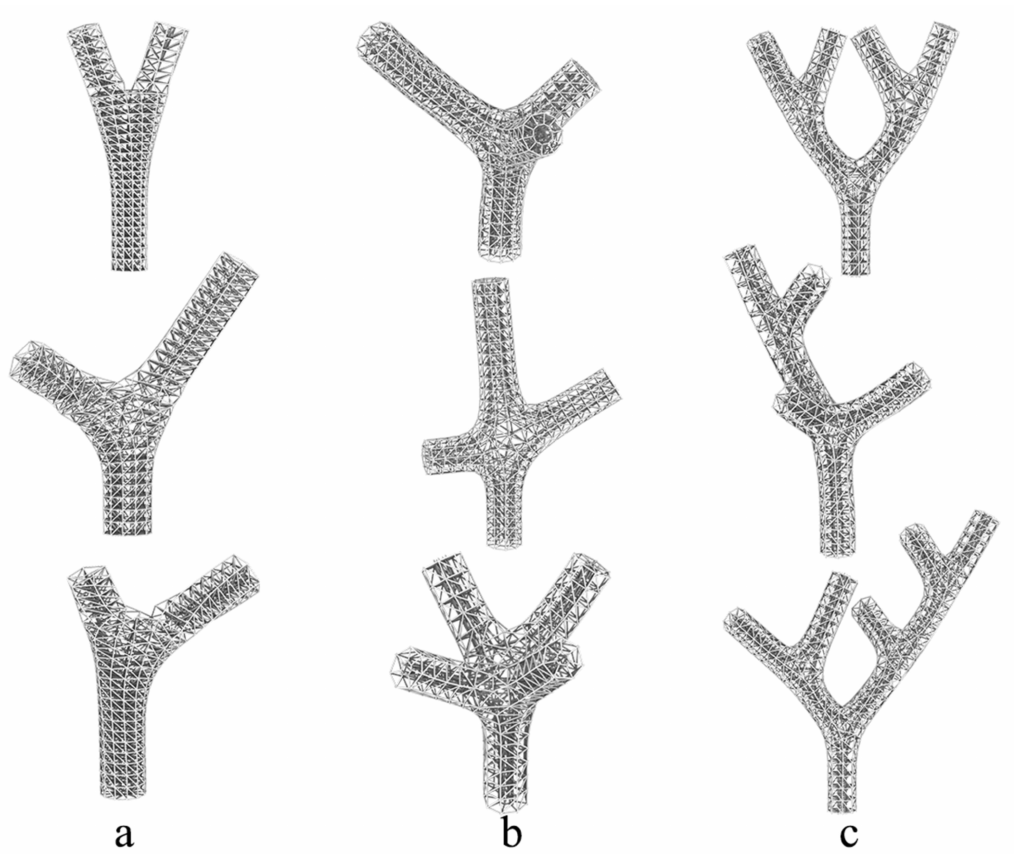
Figure 11. Examples of possible inputs and their generated lattice: ( a ) two-branch geometry; ( b ) multi-branch geometry; ( c ) multi-level-branch geometry.